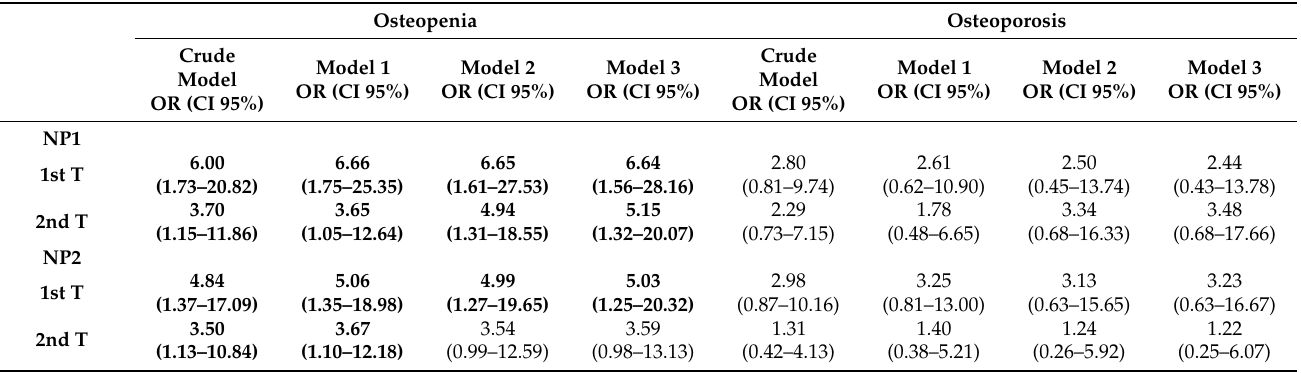
Table 4. Multivariate logistic regression between nutrient pattern 1 and nutrient pattern 2 tertiles, and bone mineral density categories of postmenopausal women. Osteopenia